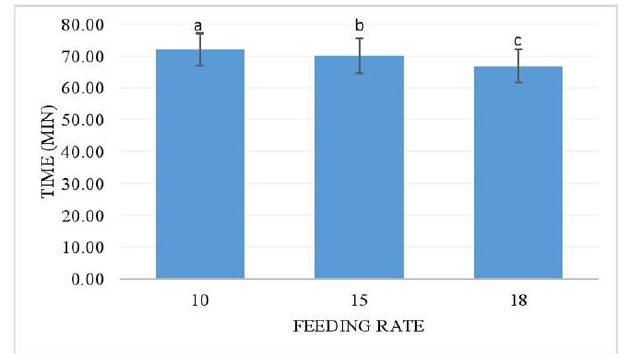
Figure 5: Effect of feeding rate on composting time